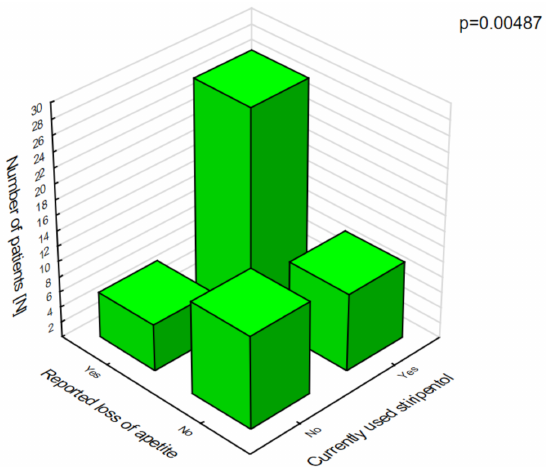
Figure 6. Stiripentol and loss of appetite.